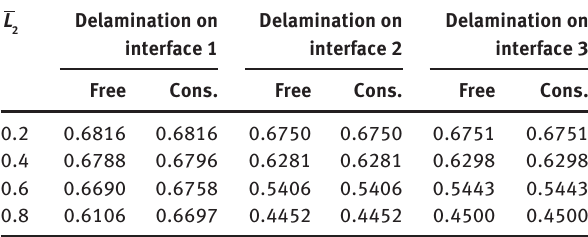
Table 10 Dimensionless fundamental frequencies of the delami- nated beams with clamped-free boundary conditions ( L/h = 15).